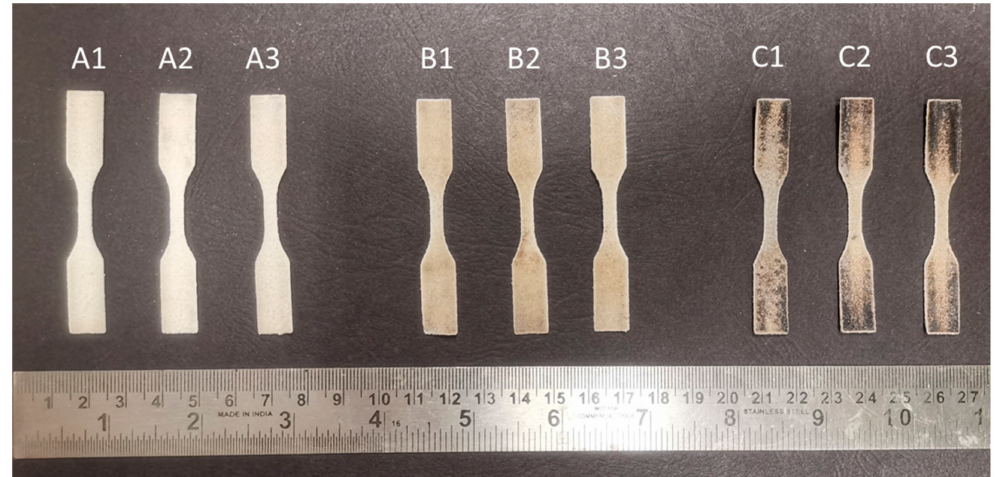
Figure 6. Multi-layered tensile test specimens of PPSF with three sets of laser power, scan speed and energy density combinations, which referring to Table